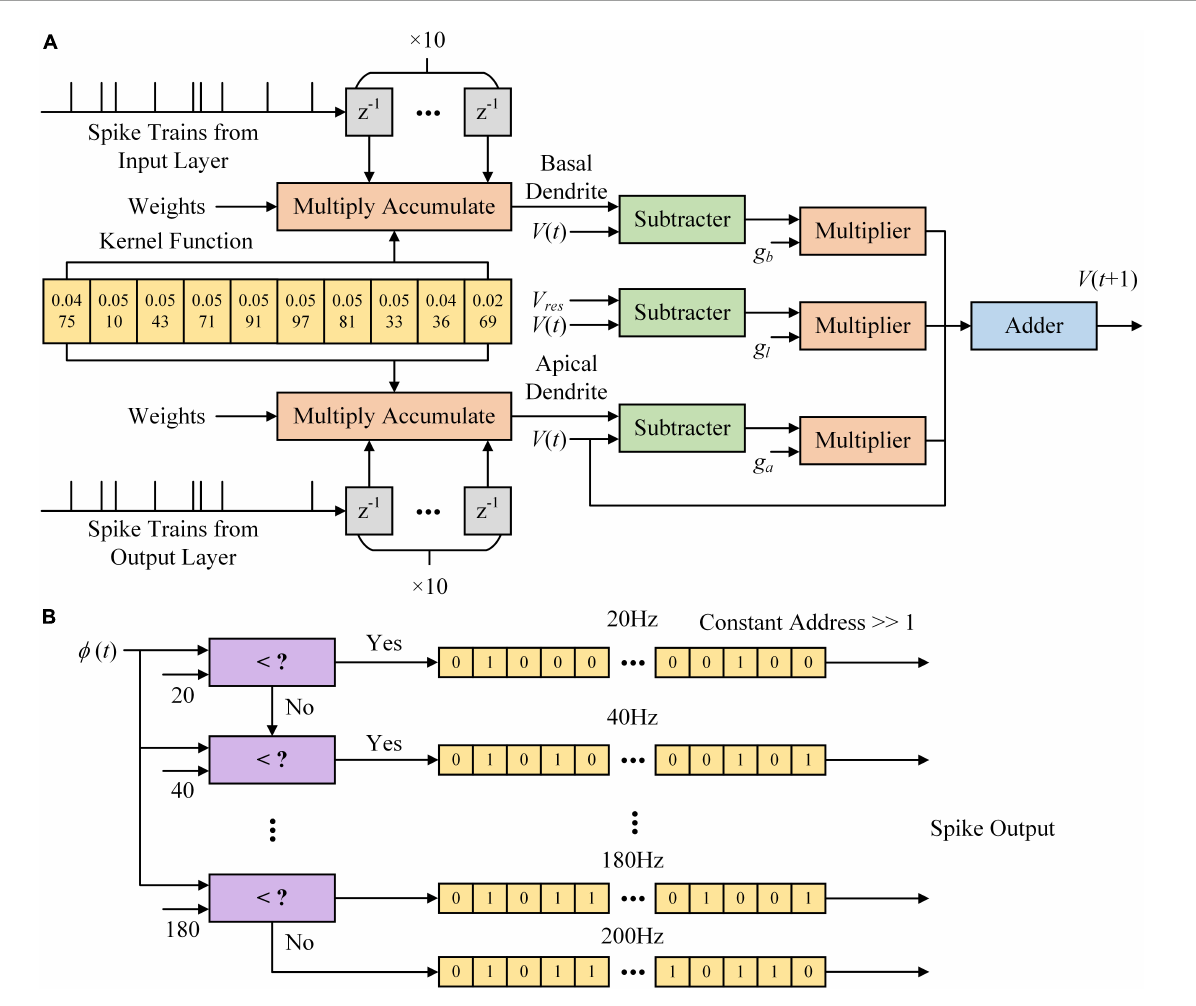
FIGURE4 Multi-compartment leaky integrate-and-fire (MLIF) model implemented on the field-programmable gate array (FPGA). (A) The architecture of somatic voltage used in the MLIF model. (B) The architecture of the Poisson process is used to generate spike trains based on the firing rate of the MLIF model. Spike trains with different firing rates are stored in memory. When a spike output is read out, the constant address is shifted right a